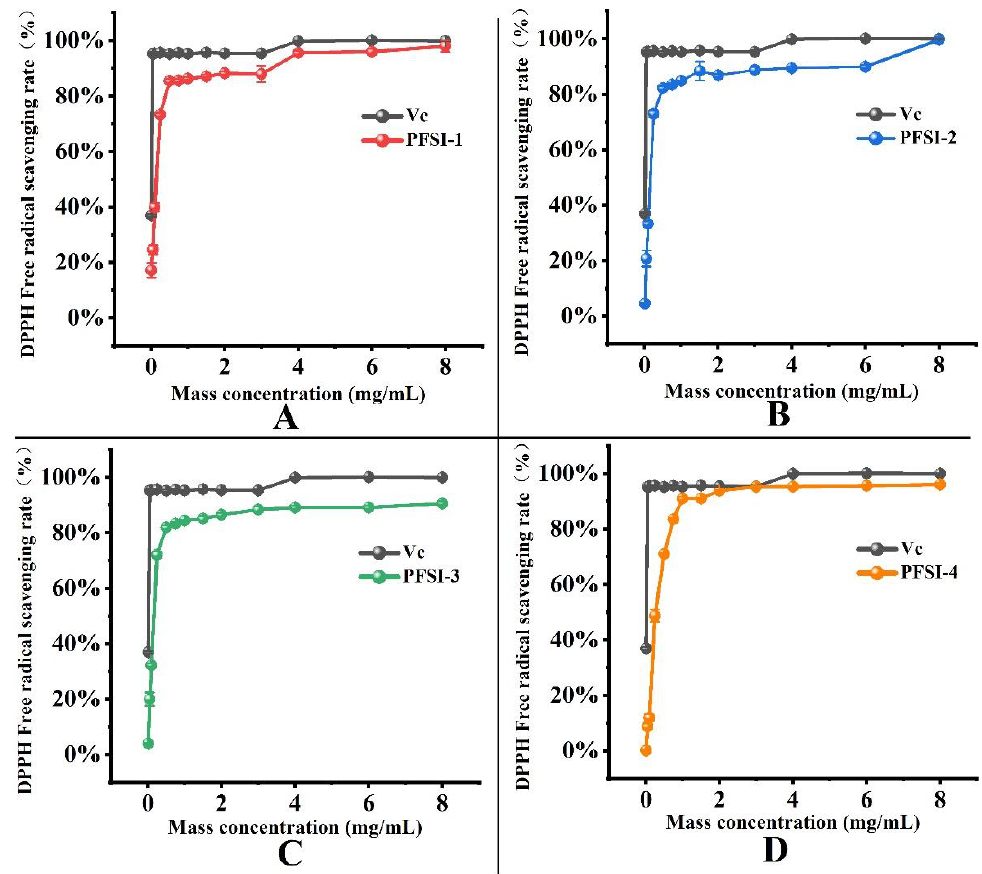
Figure 9. Comparison of the scavenging rate of DPPH · radicals by V C and PFSI. (( A – D ) represent samples of PFSI-1, PFSI-2, PFSI-3 and PFSI-4, respectively).